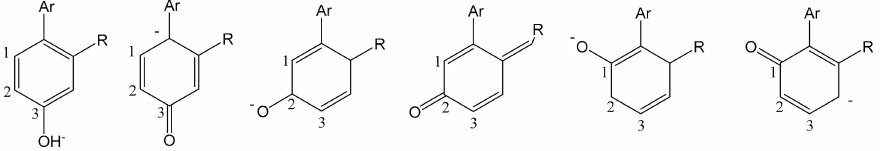
Figure 3. Resonant structures of Schisantherin A after the methyl group was